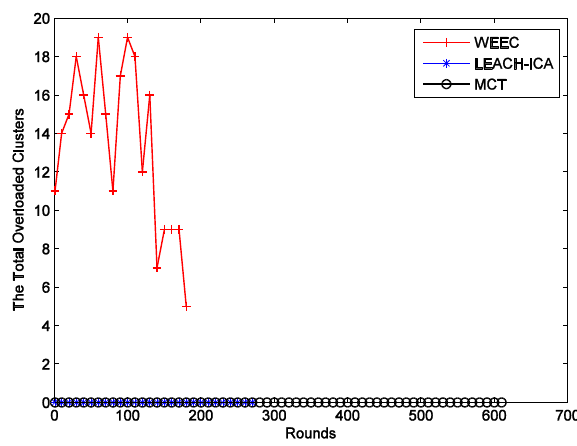
Figure 17. Total number of overloaded clusters.